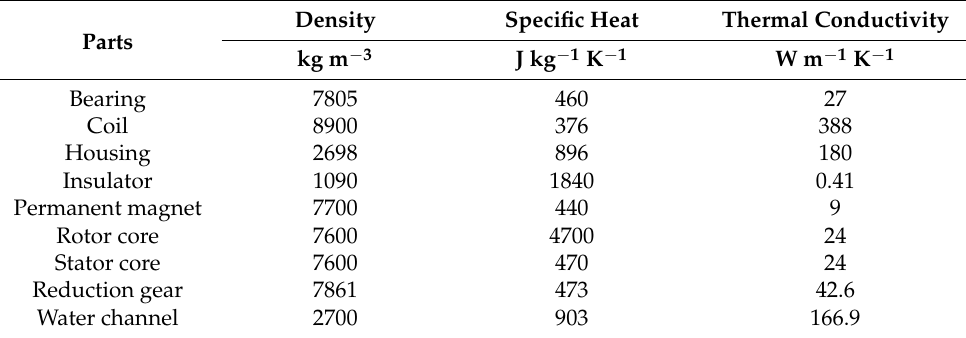
Figure 4. Flow results according to height of enhanced models with vortex generators: ( a ) single type (h = 2 mm); ( b ) single type (h = 3 mm); ( c ) single type (h = 4 mm); ( d ) pair type (H = 2 mm); ( e ) pair type (H = 3 mm); ( f ) pair type (H = 4 mm). Table 1. Thermal properties of the in-wheel motor